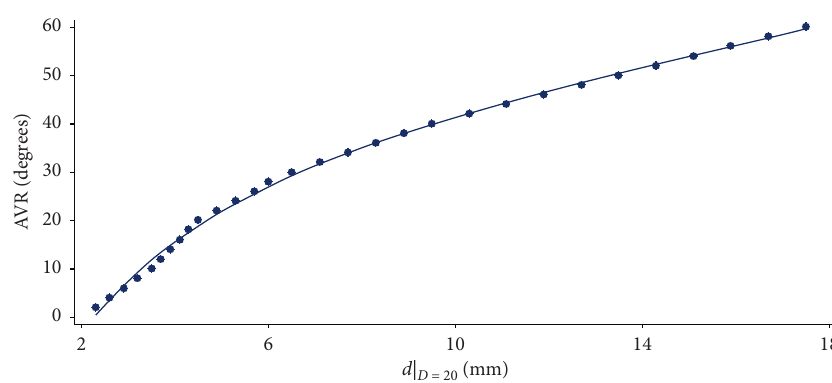
Figure 2: Adjustment of the data in column D � 20 of Raimondi’s tables to the curve.